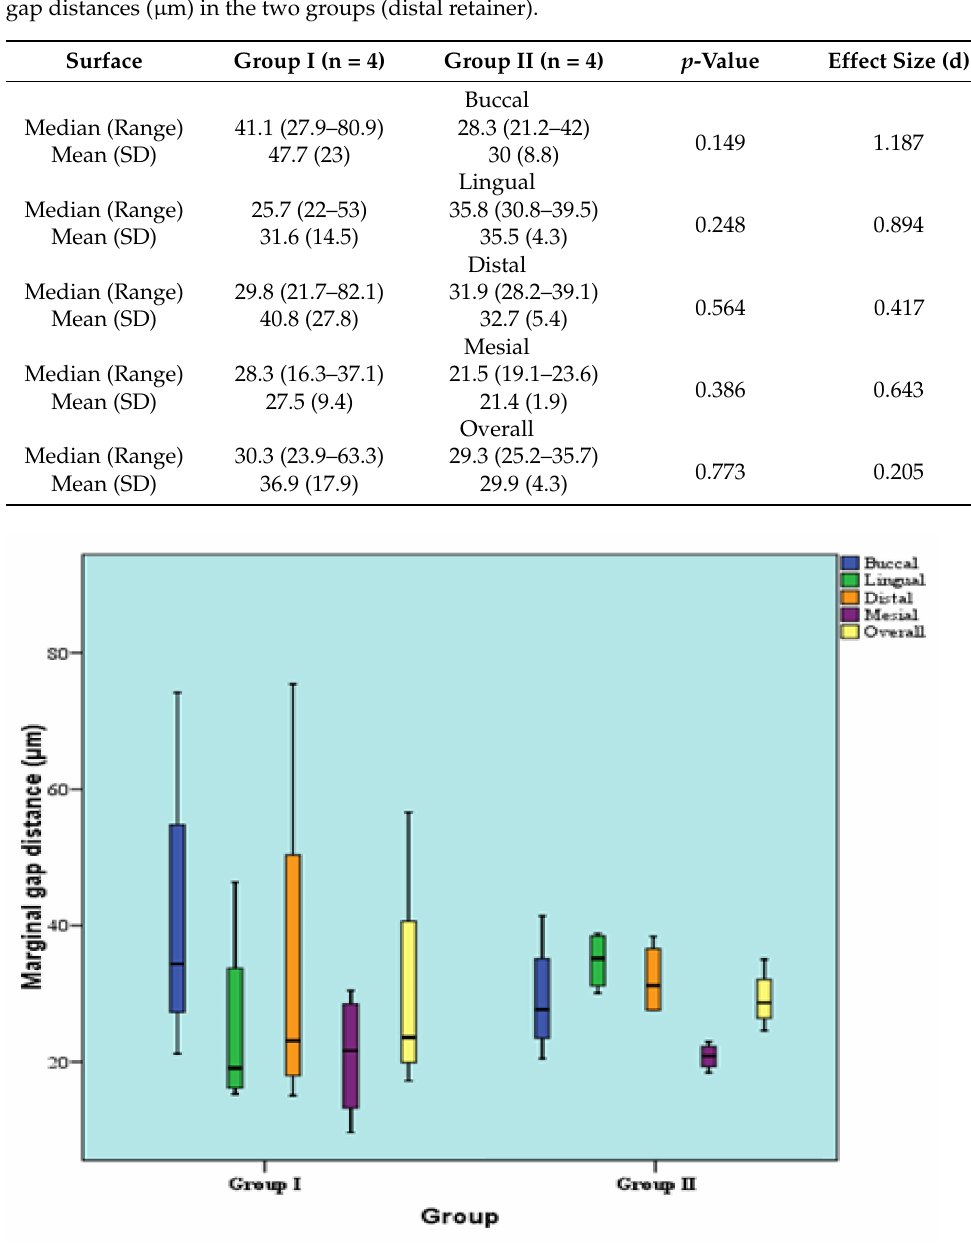
Table 2. Descriptive statistics and results of Mann–Whitney U test for comparison between marginal gap distances ( µ m) in the two groups (distal retainer).